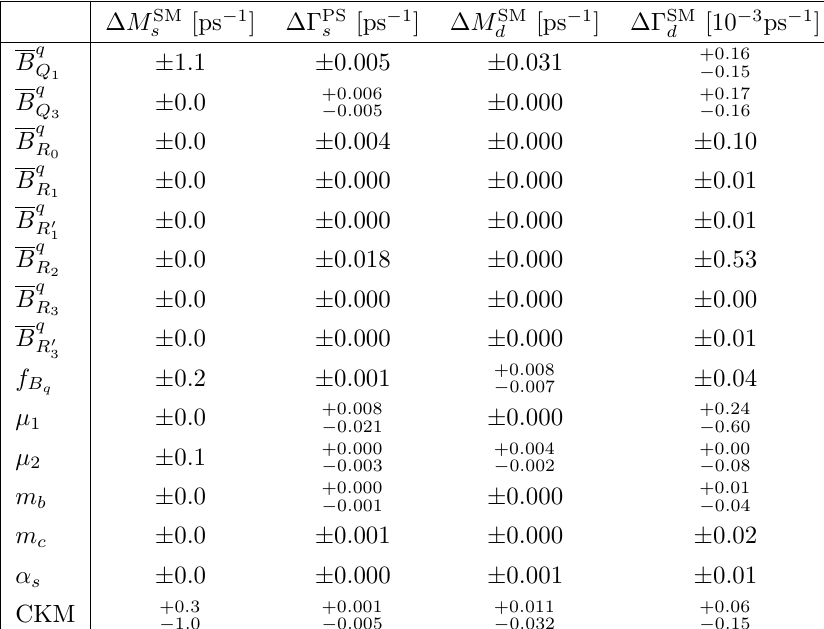
Table 4 . Individual errors for the B s and B d mixing observables. Open